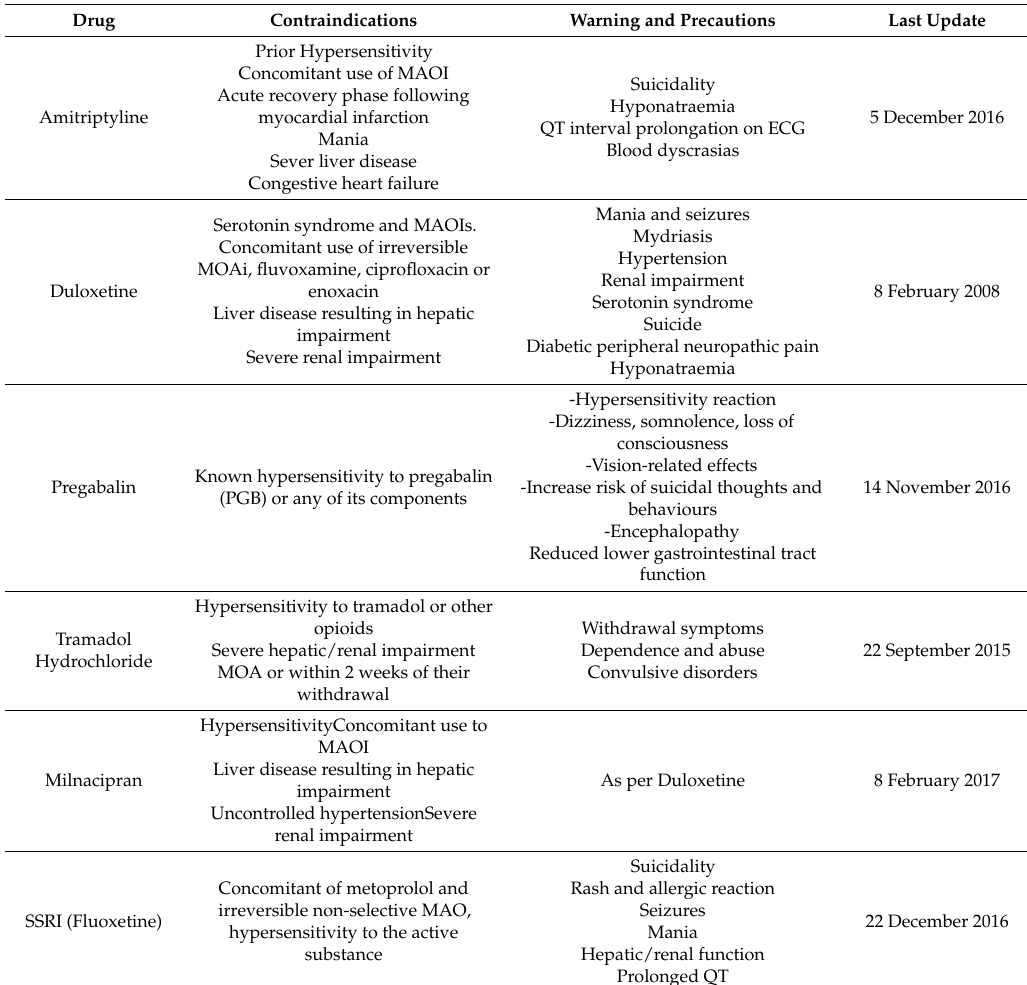
in fibromyalgia syndrome (FMS) as per summary of product characteristic